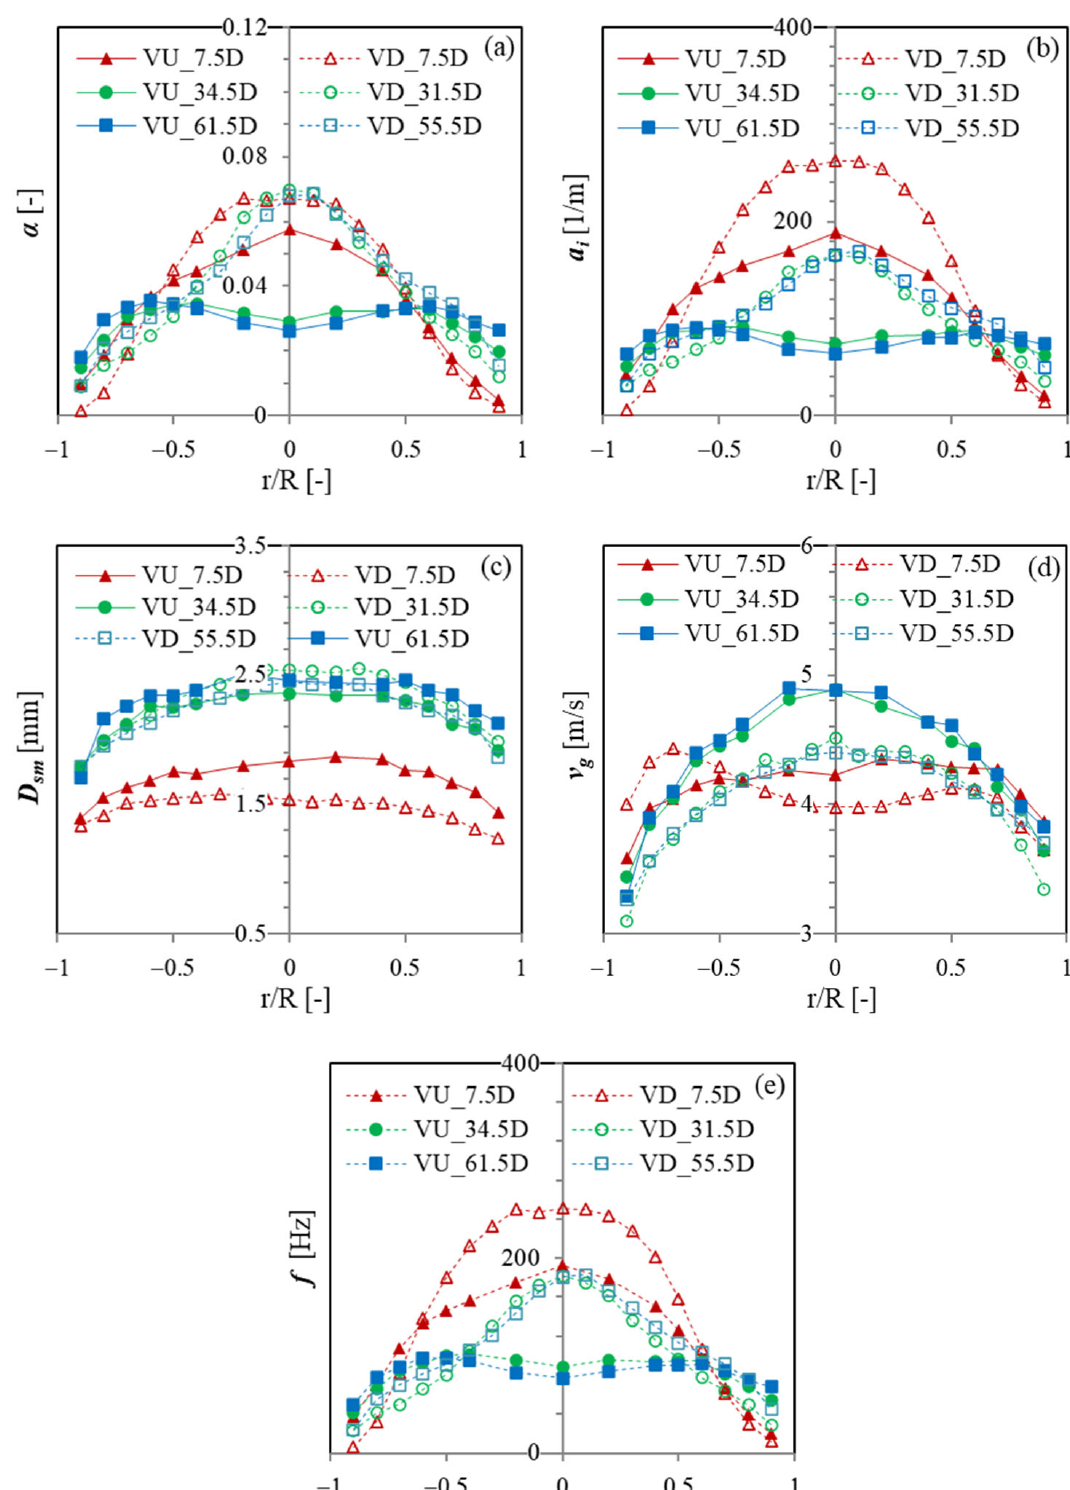
Figure 9. Comparison of interfacial structure parameters between VU (Run 2) and VD (Run 4) two-phase flows, ( a ) void fraction, ( b ) interfacial area concentration, ( c ) bubble Sauter-mean diameter, ( d ) bubble velocity, and ( e ) bubble frequency.